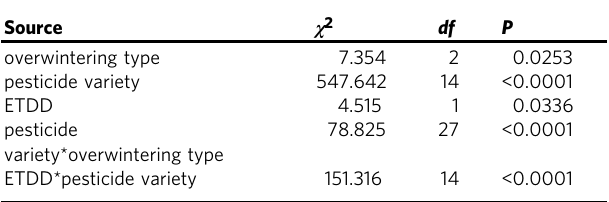
Table 1 Linear mixed model for the effects of overwintering type, pesticide variety and degree-days of effective temperatures (ETDD) during the growing season on weighted pesticide resistance level (weighted logRR) using Chi-square test.